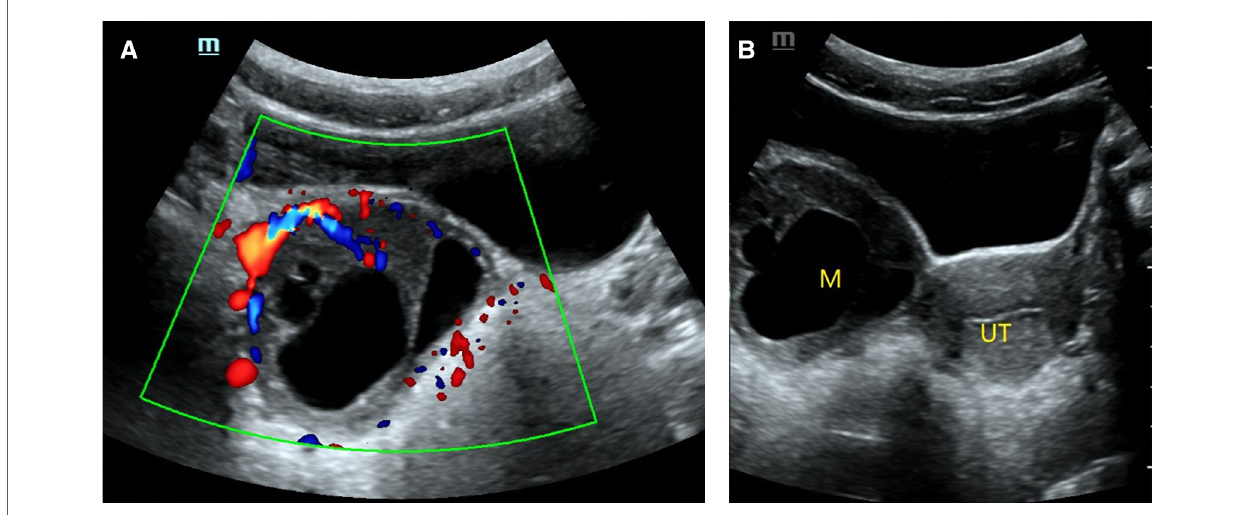
FIGURE 5 O-RADS 5, pathology: moderate differentiated Sertoli-leydig cell tumor. ( A ) Multilocular cyst, solid elements, color score 3; ( B ) The mass was located on the right side of the uterus. M, mass; UT,